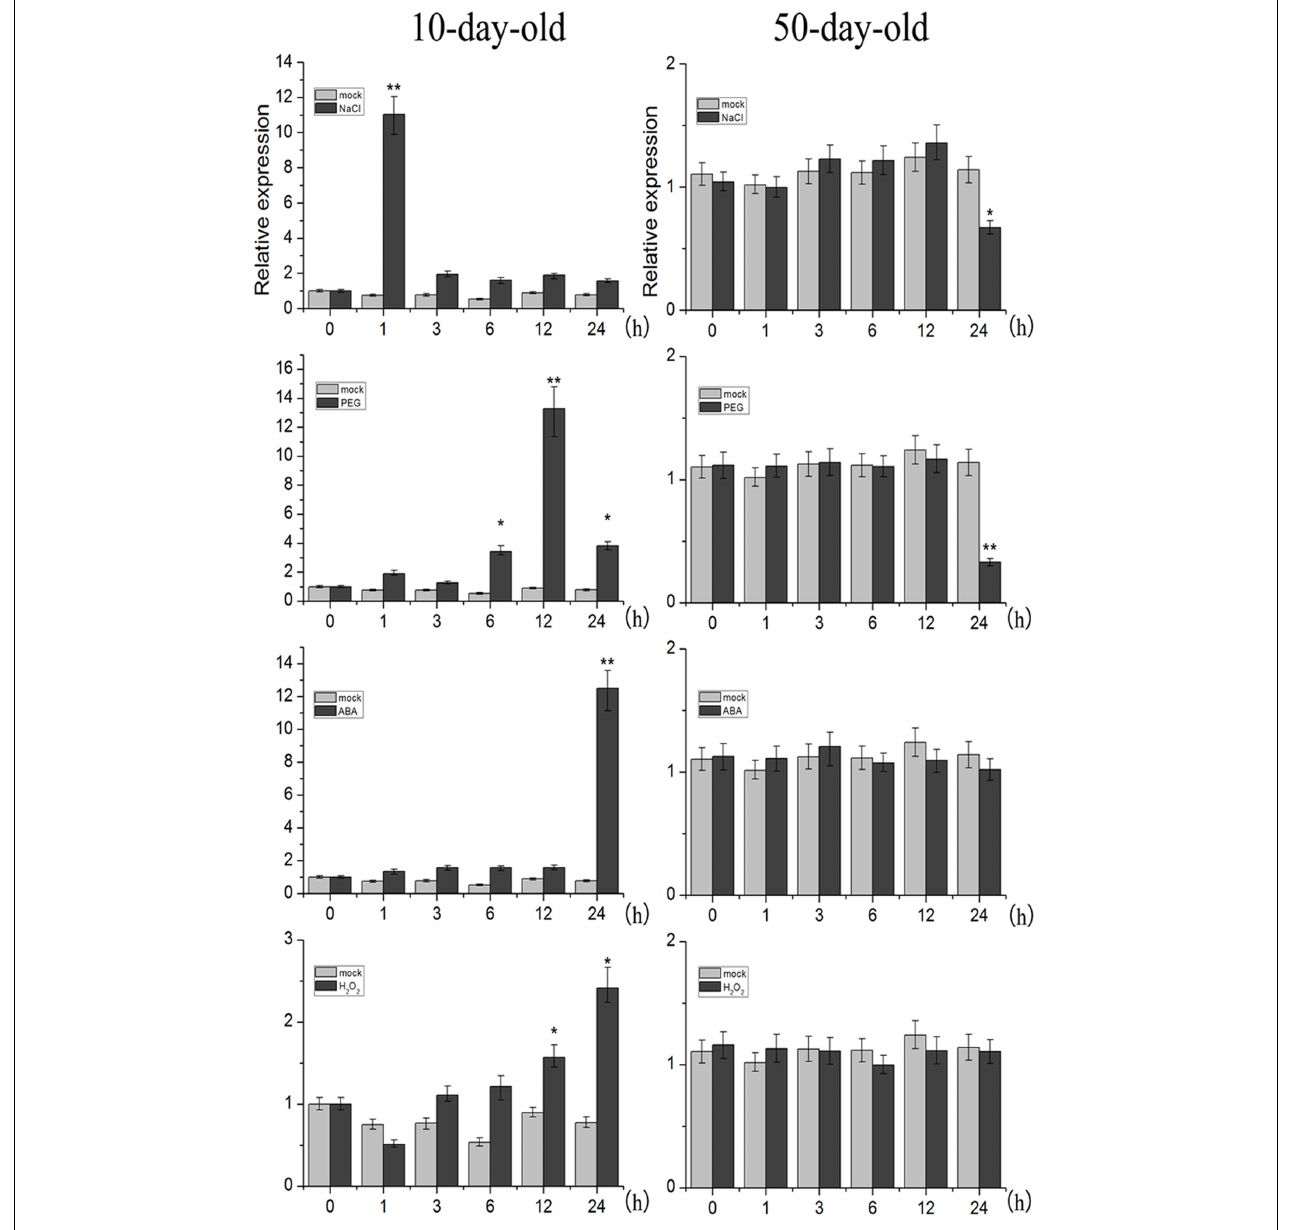
FIGURE 2 | Expression patterns of TaNAC2D . The 10-day-old wheat seedlings and the 50-day-old mature wheat plants were treated with NaCl, PEG6000, ABA, and H 2 O 2 , transcript levels of TaNAC2D in wheat leaves were determined by qRT-PCR and normalized to TaActin . Data are means ± SE of three biological replicates. Asterisks indicate significant differences from mock ( ∗ P < 0.05, ∗∗ P <